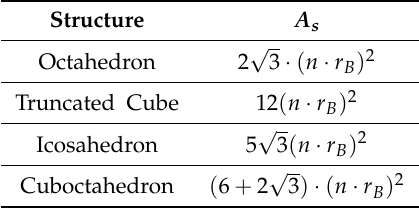
Table 7. Surface area A s for the polyhedra, where r B is the bond length for